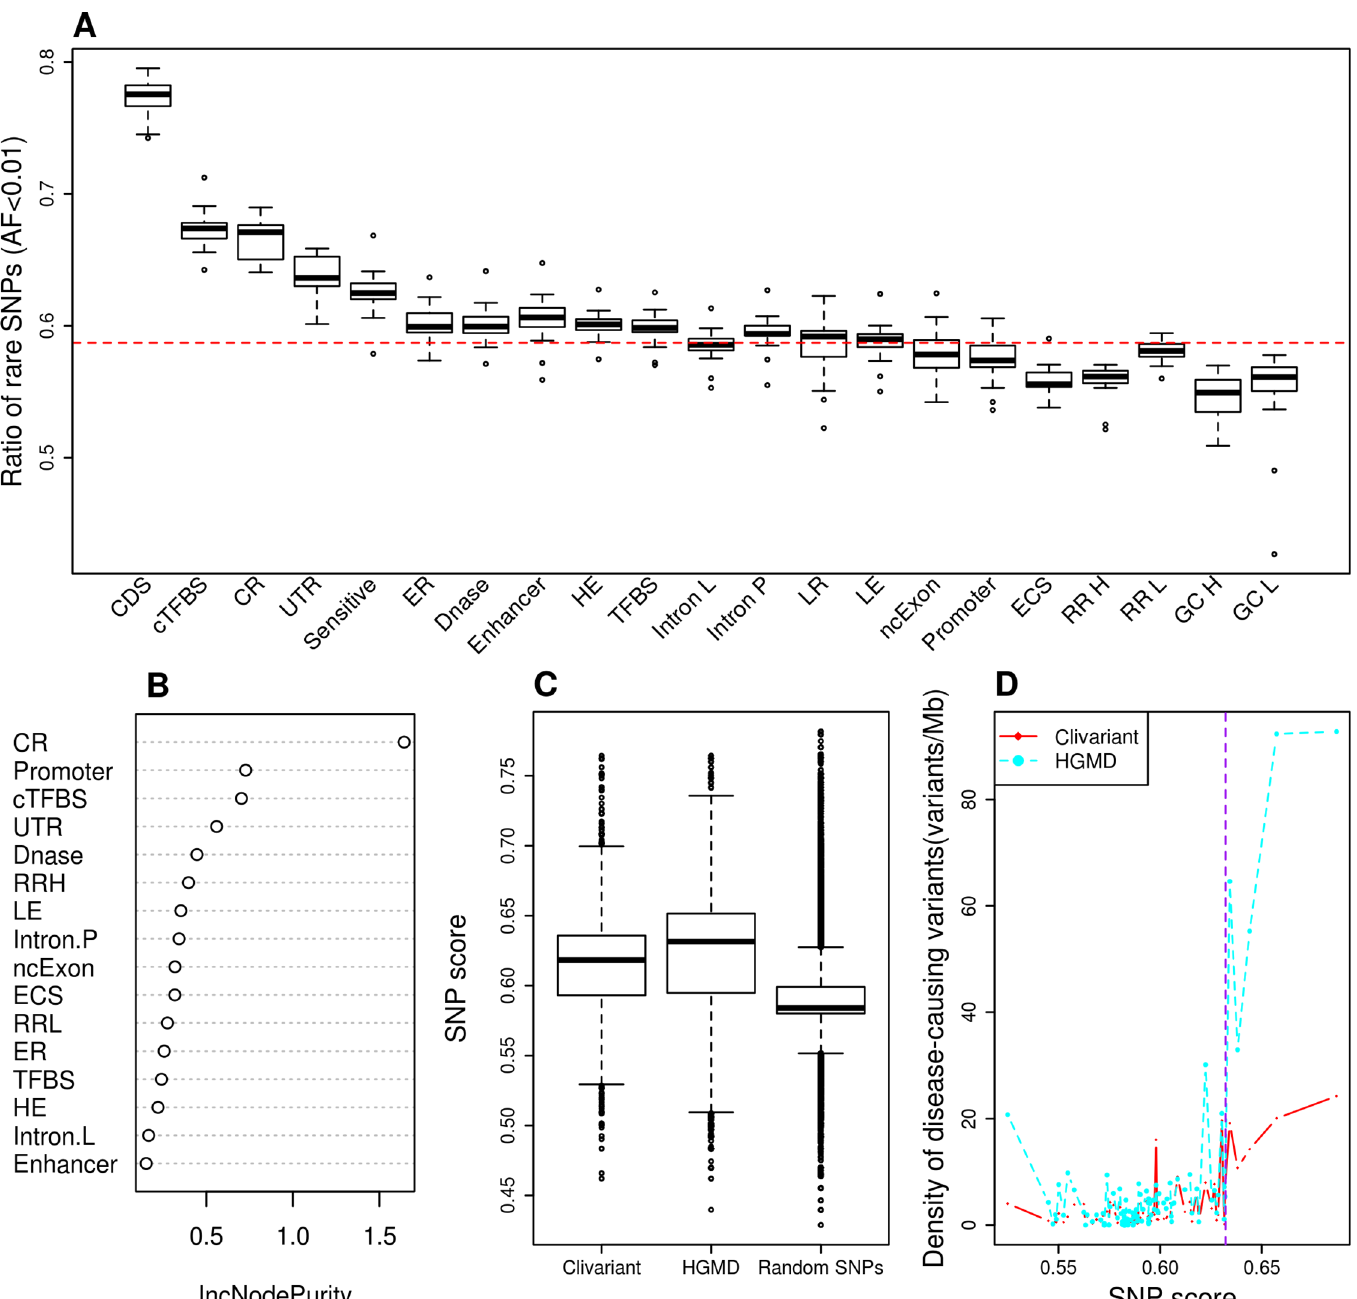
Fig 1. Construction of the rare SNP model. A. Fraction of rare SNPs (allele frequency < 0.01) according to different genome features (see S1 Table and Methods for feature details). Each box shows rare SNP fraction across all human chromosomes, except chr. Y. CDS: coding sequence; cTFBS: conserved transcription factor binding site; CR: evolutionarily conserved region; UTR: untranslated region; Sensitive: region with high rate of rare SNP defined in [10], ER/LR: early and late replicated region; DNase: DNase I hypersensitive site; HE/LE: high and low expressed region; Intron L/Intron P: intron of lncRNA/of protein coding gene; ncExon: non coding exon; ECS: evolutionarily conserved structure; RR H/RR L/GC H/GC L: high recombination rate, low recombination rate, high GC content and low GC content regions. The red dotted line represents the average fraction of rare SNPs across the genome. B. Feature importance as measured by IncNodePurity. We only show here features that passed feature selection. C . Distribution of SNP scores for random SNPs and for clinical variants from the Clivariants and HGMD databases. Random SNPs here are a set of 1M random intergenic SNPs from the 1000 Genome project. D . Correlation of SNP scores with densities of disease-causing variants. Genome positions were sorted by SNP score and split into 20 Mb intervals. The plots show the average SNP score and density of disease-causing variants for each interval. The purple dotted line shows cutoff used for defining high SNP score